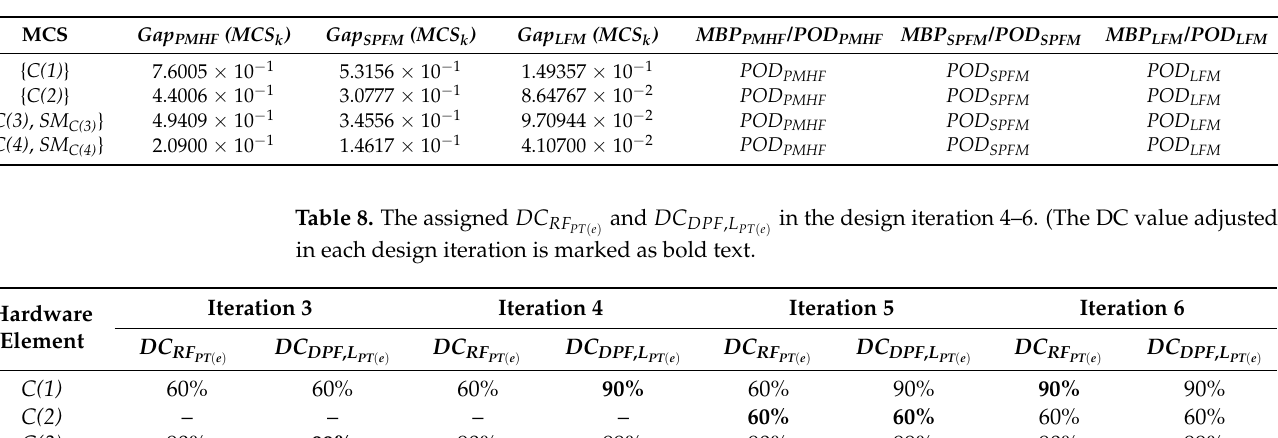
Table 7. List of MCSs and their failure probabilities with updated system hardware architecture.